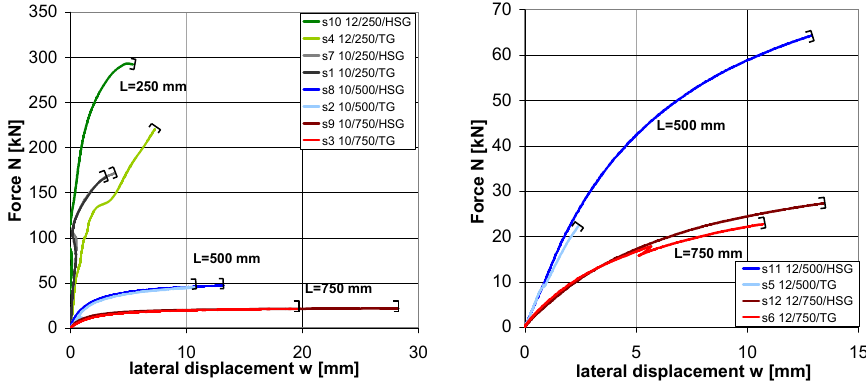
Figure 7: Load-Deformation behaviour of buckling tests at glass panes with monolithic section with centric normal force (left) as well as with normal force and excentricity e p =3,0 mm (right).